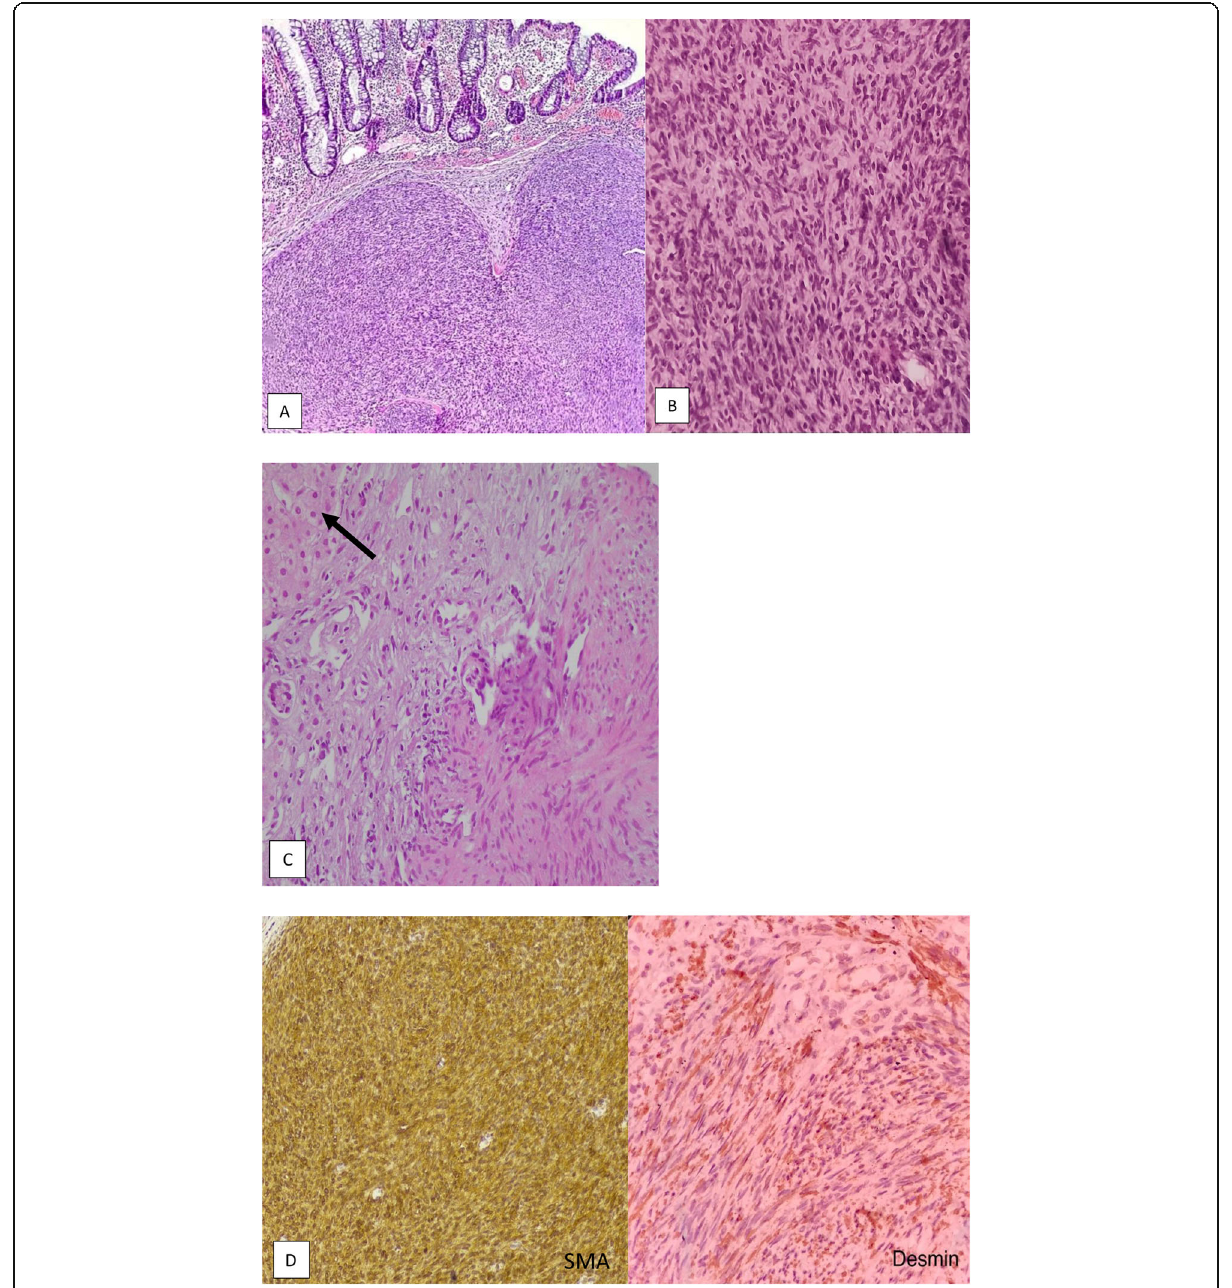
Fig. 3 Microscopic view of colon polyps, ( A )(H&E × 100), ( B )(H&E × 400), and the liver mass ( C )(H&E × 40) show intersecting fascicles of spindle cells with elongated nuclei, eosinophilic cytoplasms, mild atypia, and low mitotic activity. There is a thin rim of non-neoplastic liver tissue (white arrow). D The neoplastic cells are reactive for SMA and